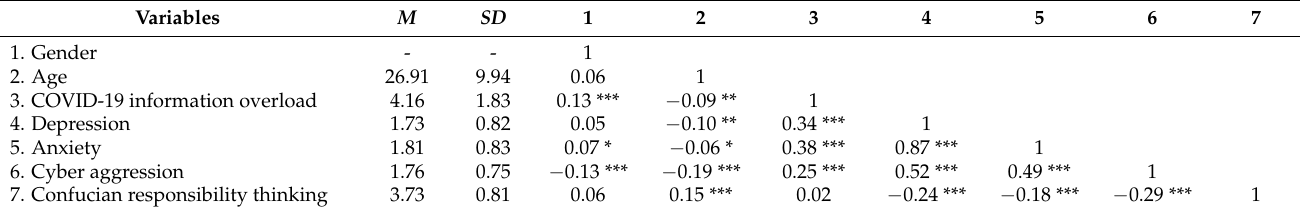
Table 1. Descriptive statistics and correlations among